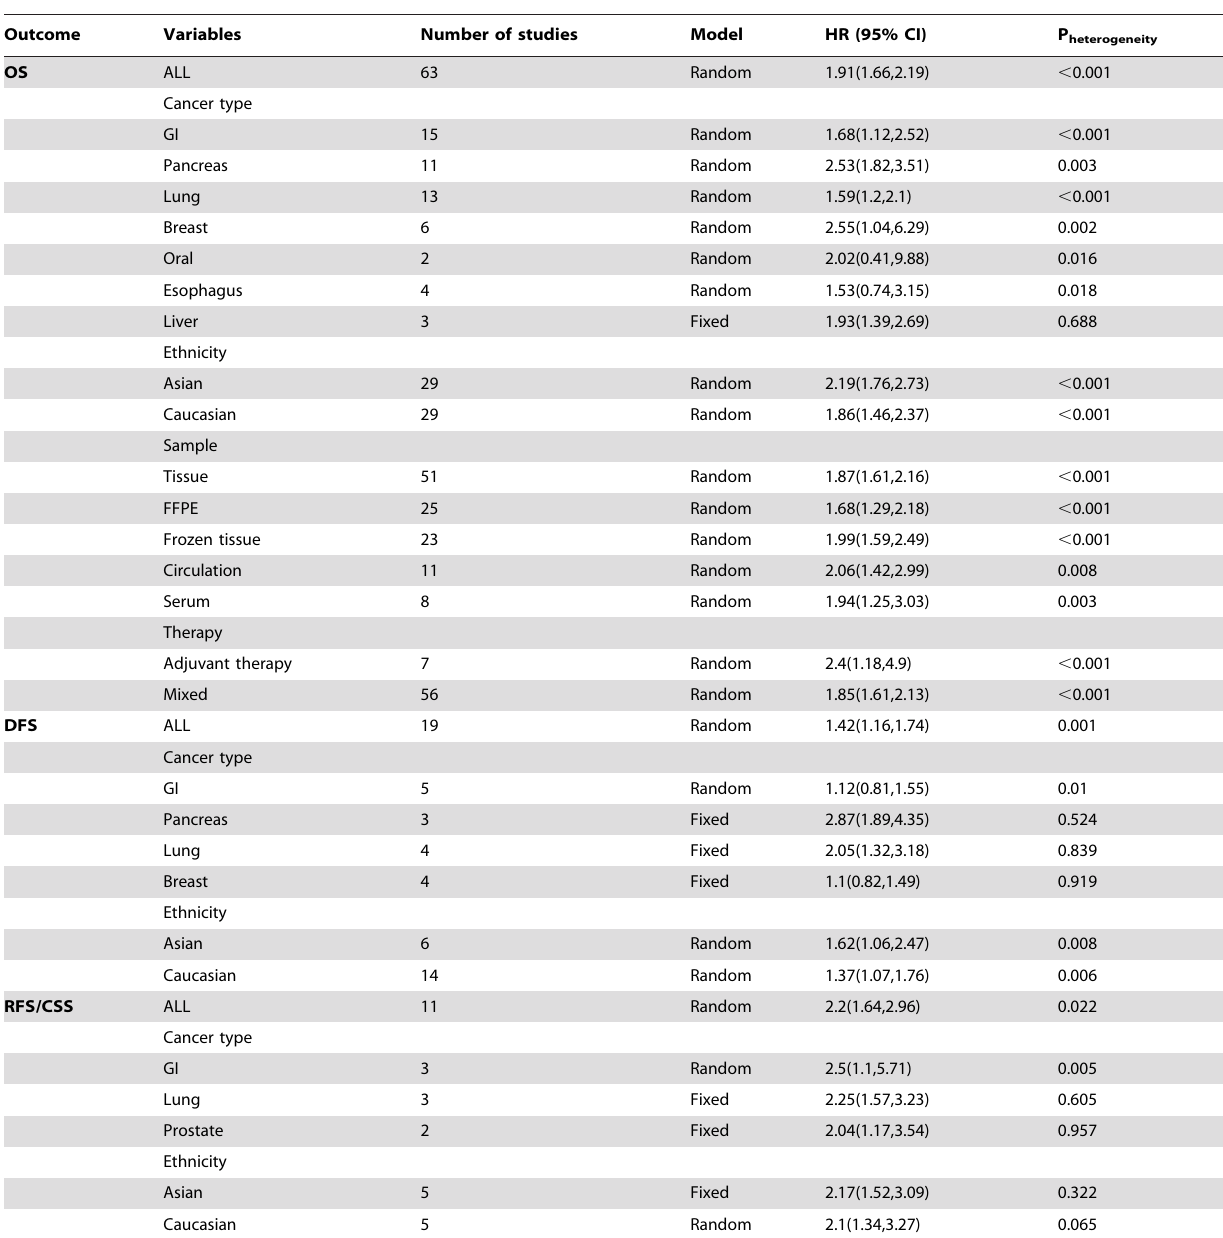
Table 2. Meta-analysis